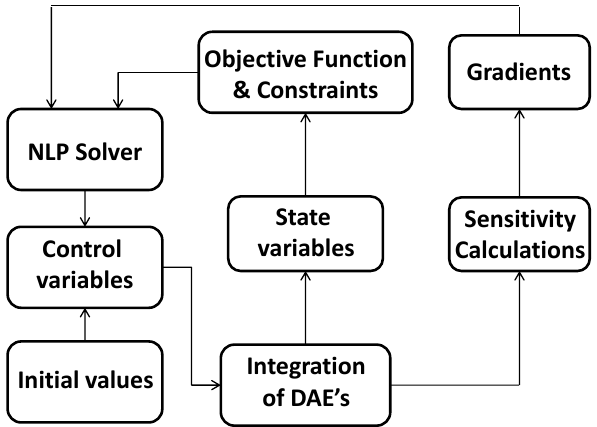
Figure 9. Sketch of the sequential approach used.